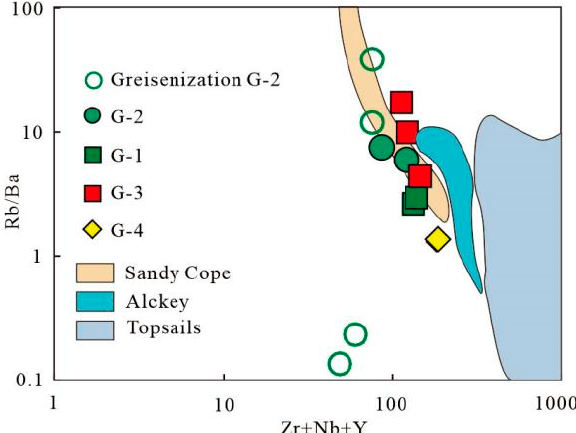
Figure 17. Rb/Ba versus Zr + Nd + Y diagrams of intrusions in Chuankou Tungsten ore field, Sandy Cope and Alckey granite represent highly fractionated granite after [58].